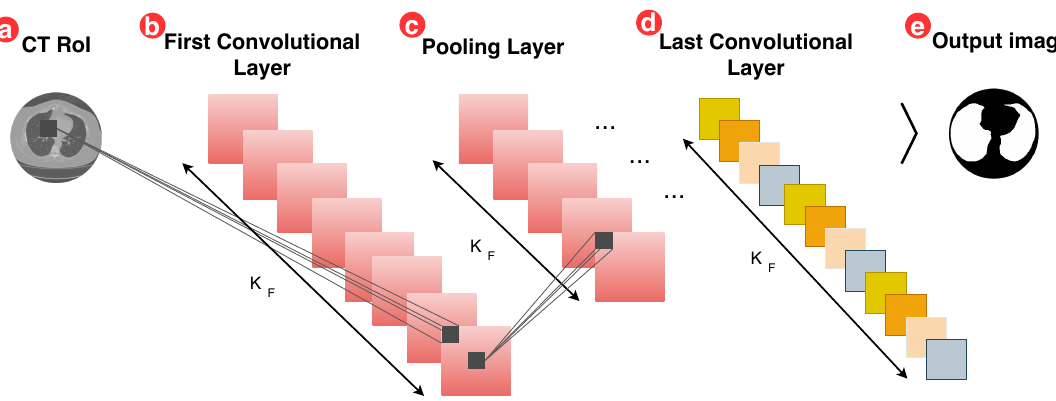
Figure 2. The ilustration of the deep features generation process on the CT images of the lung, in which the initial layers undergo a pooling process and only then form the last convolutional layer, this process makes the method less sensitive to the location of resources since the pooling method reduces sampling